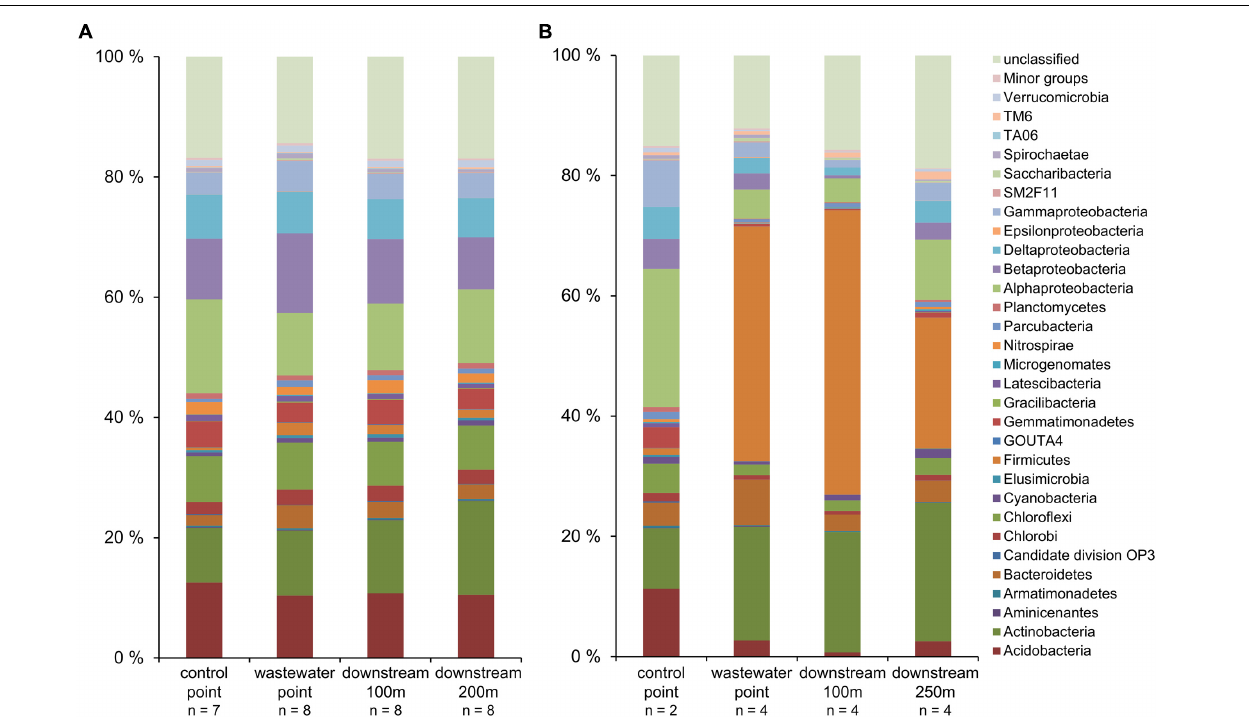
FIGURE 4 | The relative abundances of bacteria taxa ( > 1% of relative abundance in at least one sample) (A) on Keuruu and (B) on Petäjävesi study